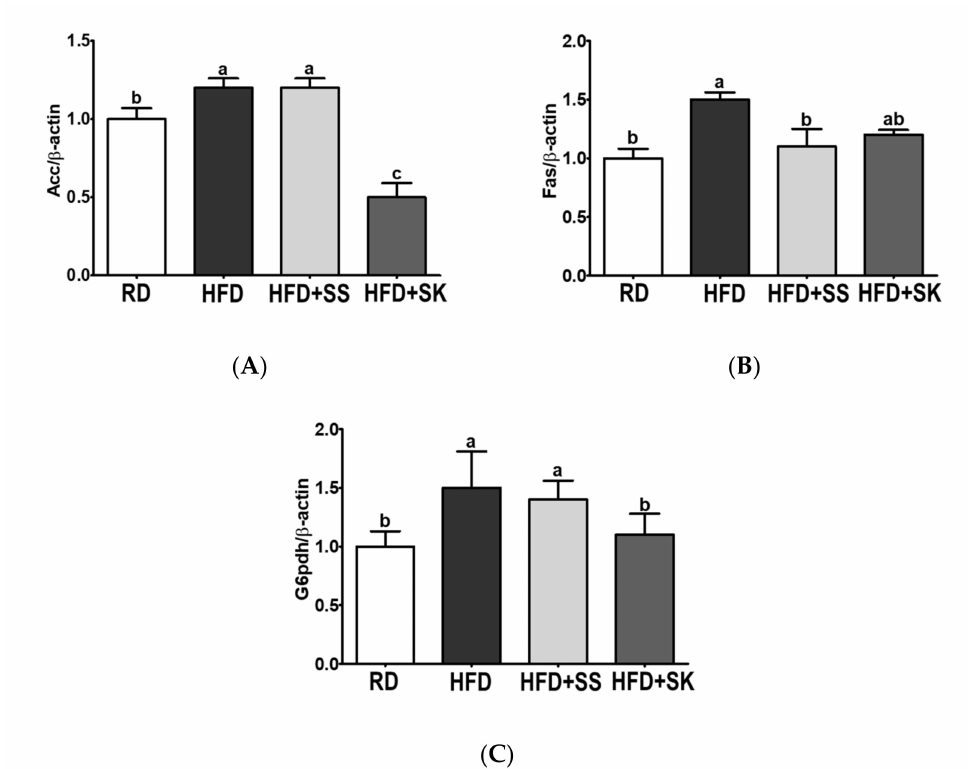
Figure 8. Effect of steamed soybean (SS) and soybean koji (SK) on epididymal adipocyte mRNA expression. Experimental rats were fed a regular diet (RD) or a high-fat diet (HFD) with 3% SS (HFD+SS) or with 3% SK (HFD+SK) for 8 weeks. ( A ) Acetyl-CoA carboxylase ( Acc ), ( B ) fatty acid synthase ( Fas ), and ( C ) glucose-6-phosphate dehydrogenase ( G6pdh ) mRNA expression was analyzed using qRT-PCR and normalized by β -actin. RD, regular diet; HFD, high-fat diet; HFD+SS, high-fat diet + 3% steamed soybean; HFD+SK, high-fat diet + 3% steamed soybean. Values are means ± standard deviation, n = 8. Data were analyzed using one-way ANOVA followed by Tukey’s post-hoc test. Means labeled without a common letter differ significantly, p <